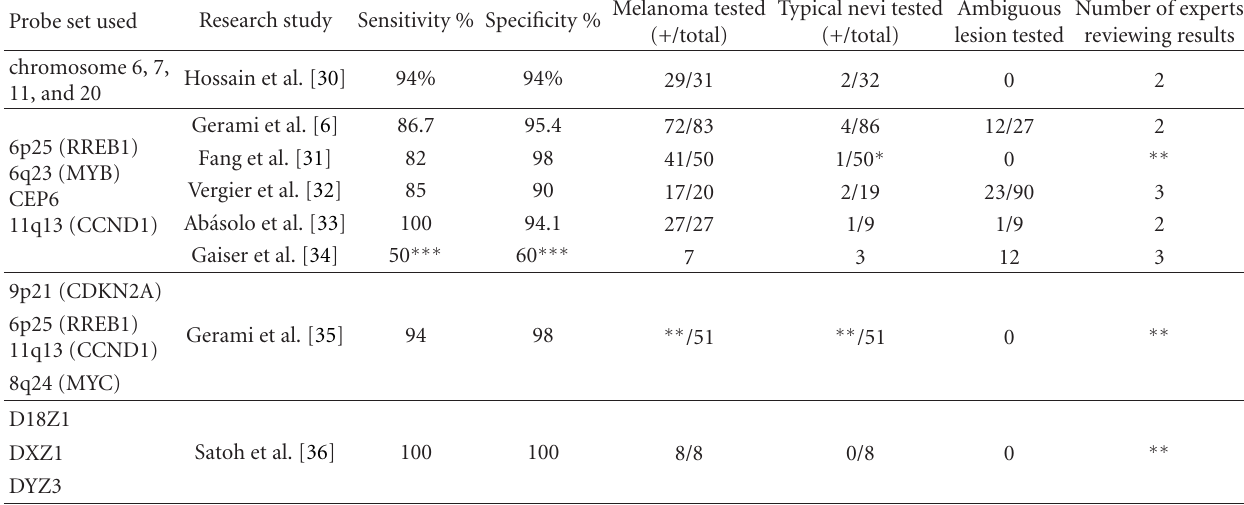
Table 2: The sensitivity and specificity of recent studies using FISH assays to identify melanoma. Probe set used